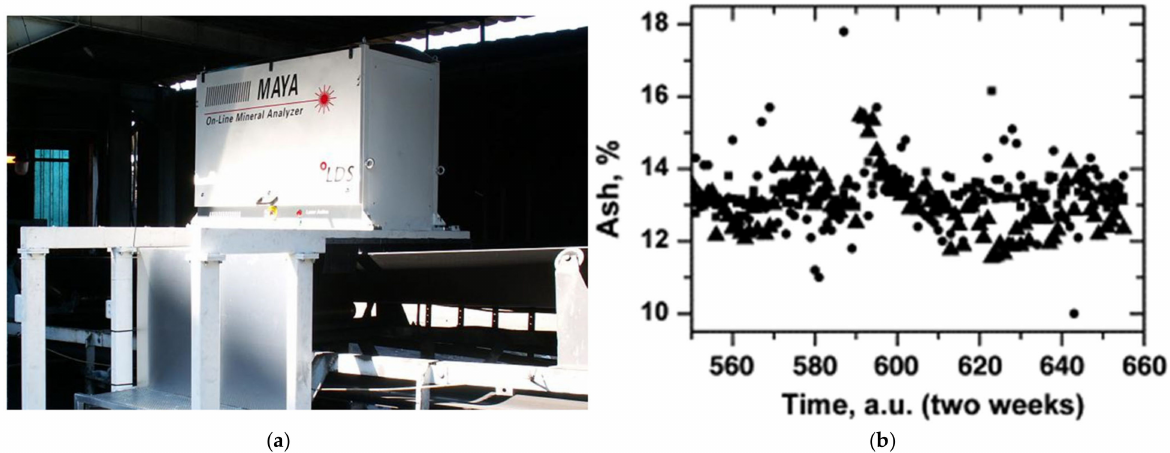
Figure 6. LIBS in-line analyzer of coal ash. ( a ) Measurement system installed at a conveyor belt (photograph: LDS Laser Detect Systems). ( b ) Real-time coal quality monitoring by LIBS (triangles) and PGNAA (squares). Reference concentrations (circles). Adapted from